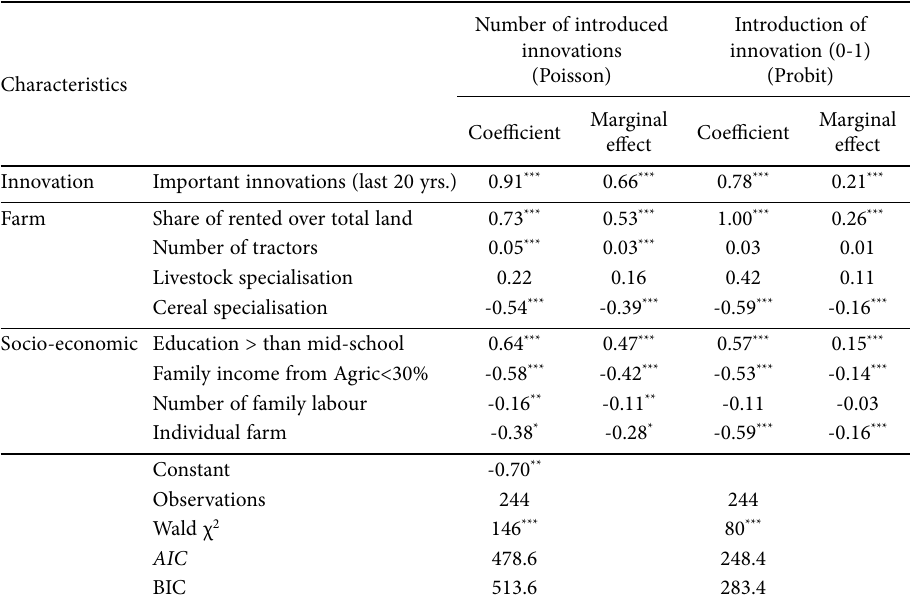
Table 6. Poisson and Probit adoption models.